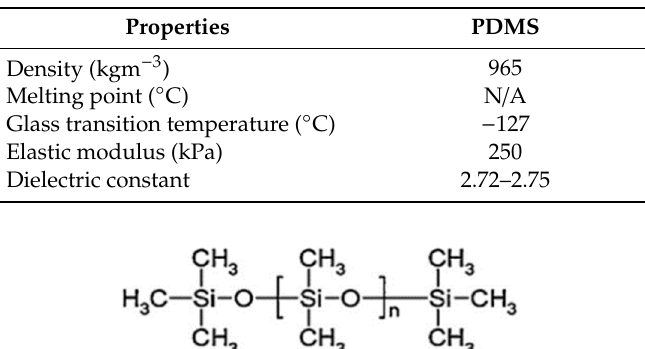
Table 6. Typical properties of polydimethylsiloxane (PDMS).